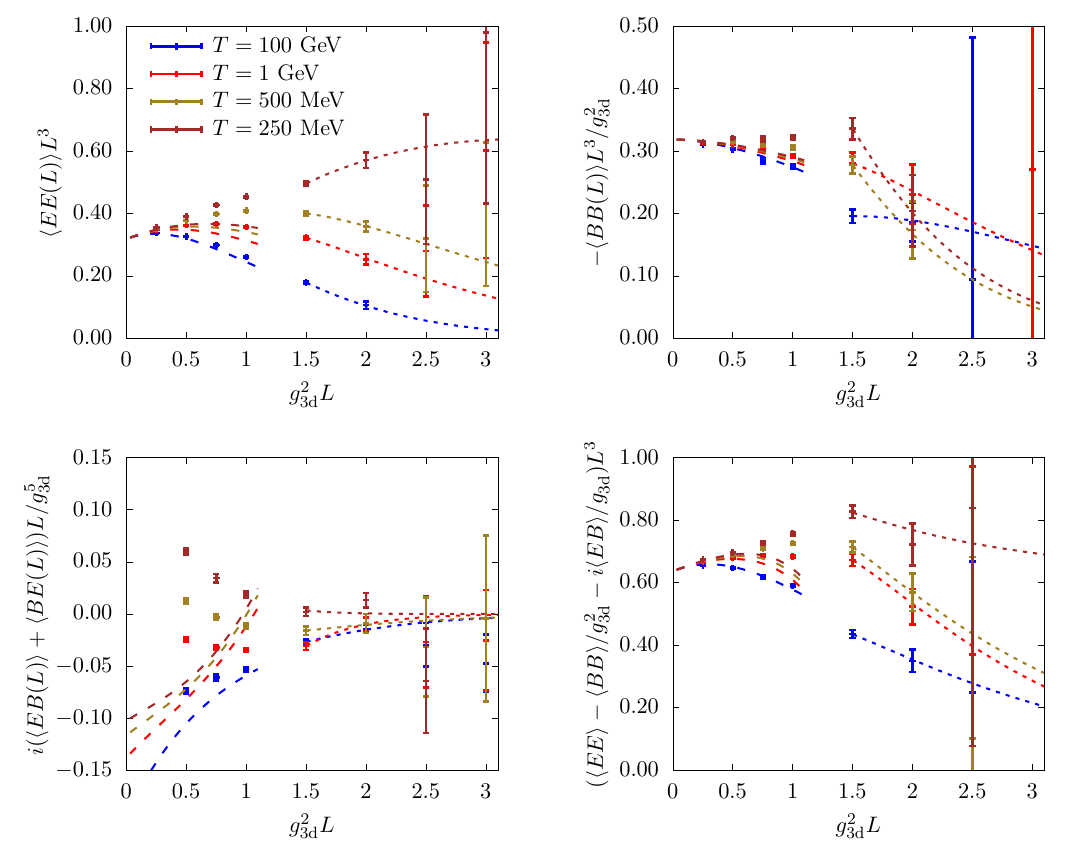
Figure 3 . Continuum-extrapolated EQCD lattice data on the three separate correlators h EE i L 3 , −h BB i L 3 /g 2 , i h EB i L/g 5 , (cf. table 1) and the d L L integrand of eq. (3.4) with modelled long 3d 3d L -tail (short dashes) and our NLO perturbative estimate (long dashes). Powers of g 2 expected leading divergence of the respective correlator,